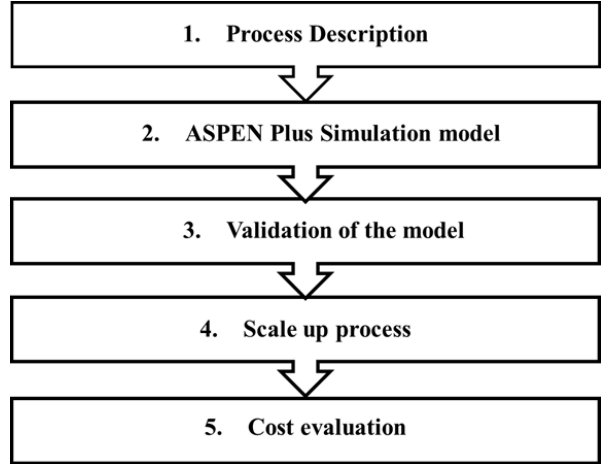
Figure 1. The sequential step for analyzing a potential commercial-scale process for catalytic decarboxylation of naphthenic acid over the HZSM-5 process.